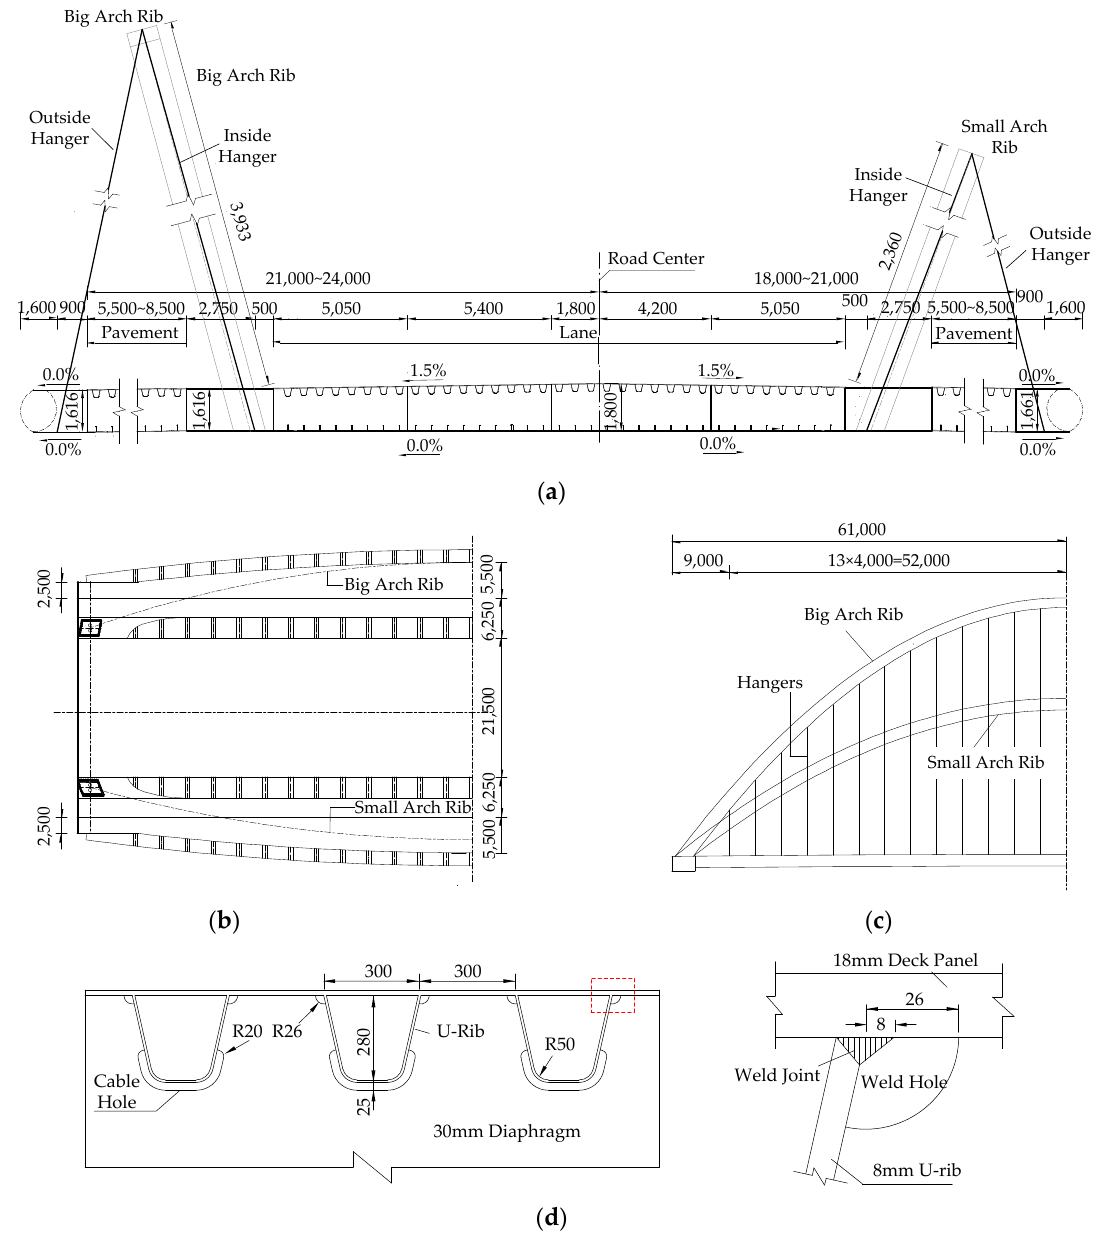
Table 1. Mechanical properties of Q345C steel.